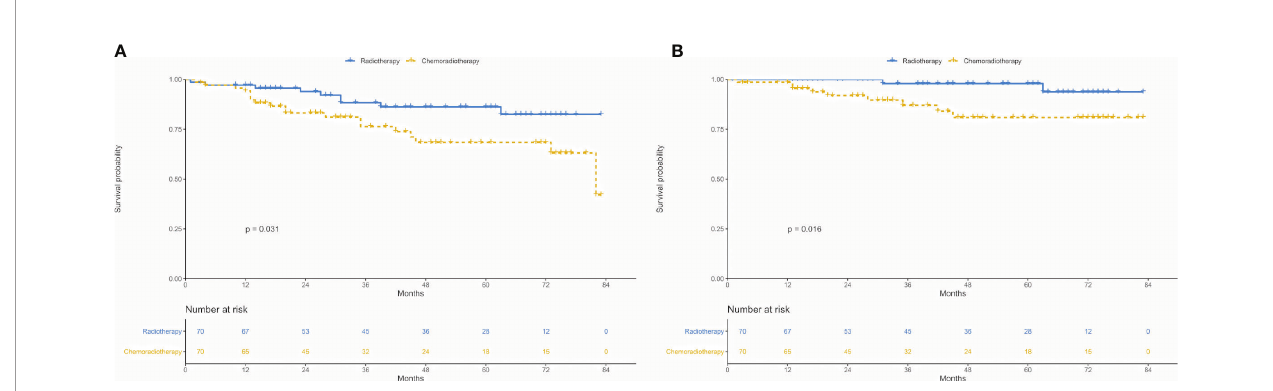
FIGURE 5 | Survival between chemoradiotherapy and radiotherapy groups in the propensity-matched cohort. (A) Overall survival. (B) Cancer-speci fi c